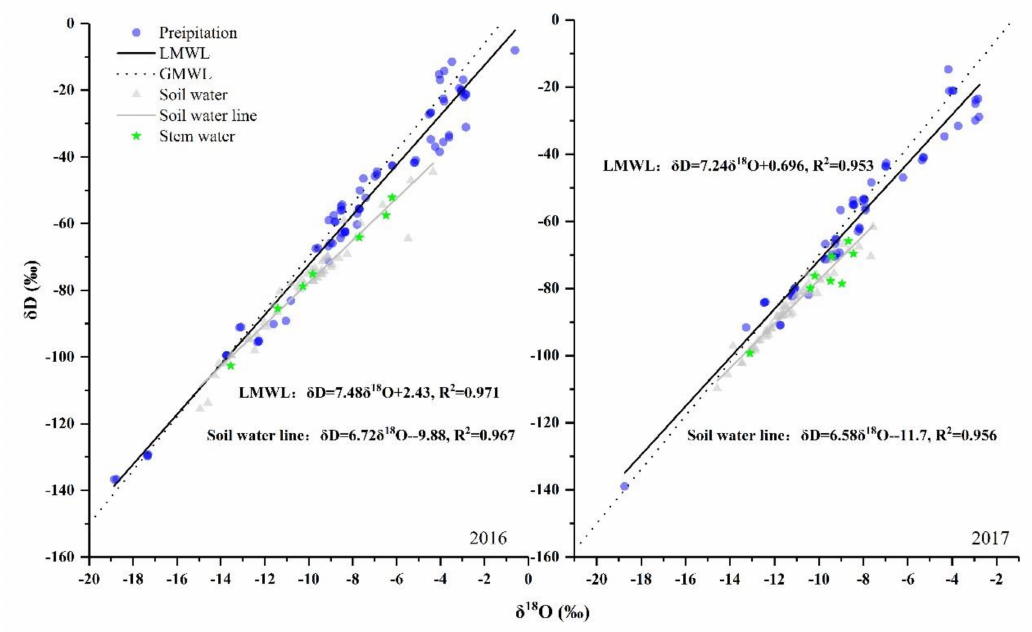
Figure 2. The correlation between δ 18 O and δ D values of precipitation, different soil depths, and stem water in 2016 and